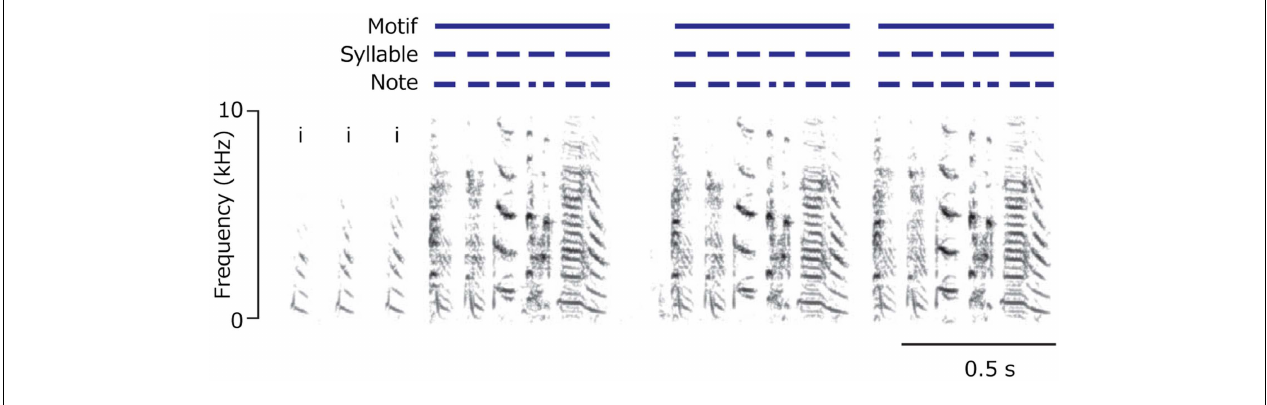
FIGURE 1 | Zebra finch song.